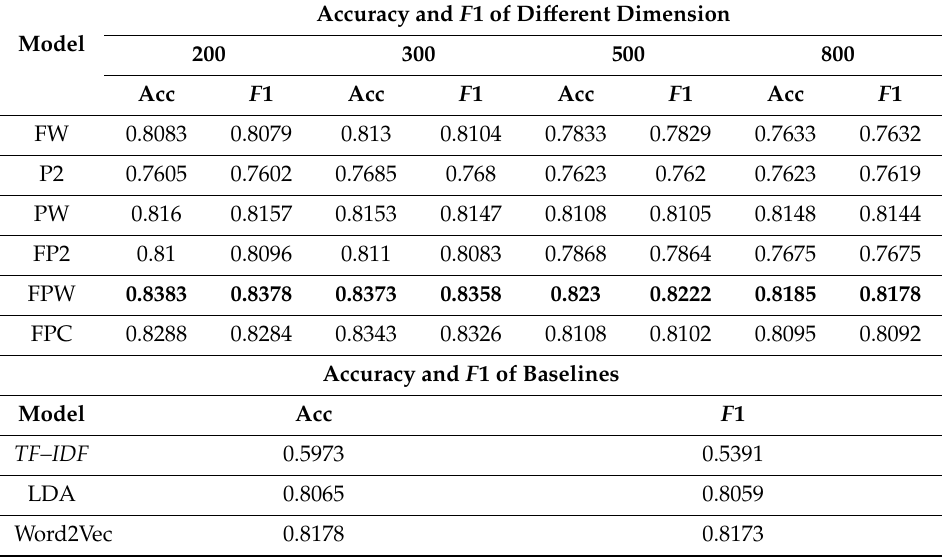
Table 9. Results of laptops in ChnSentiCorp by KNN.